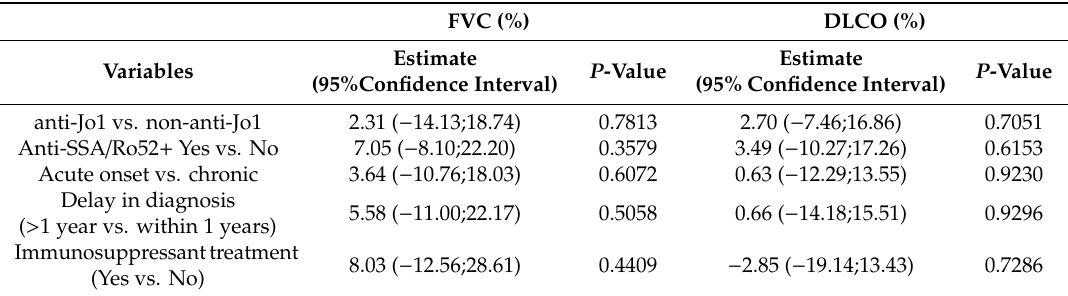
Table 3. Longitudinal multivariable mixed model of forced vital capacity (FVC) and carbon monoxide di ff usion capacity (DLCO) between anti-Jo1 and non-anti-Jo1 during follow up. FVC (%) DLCO (%) Estimate P Variables